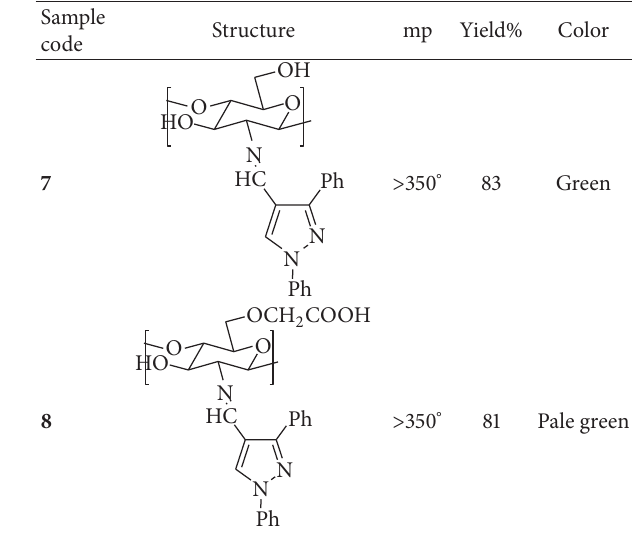
Table 1: Chemical structures, mp, yield%, and elemental analysis of CS or CMCS / Schiff-bases.